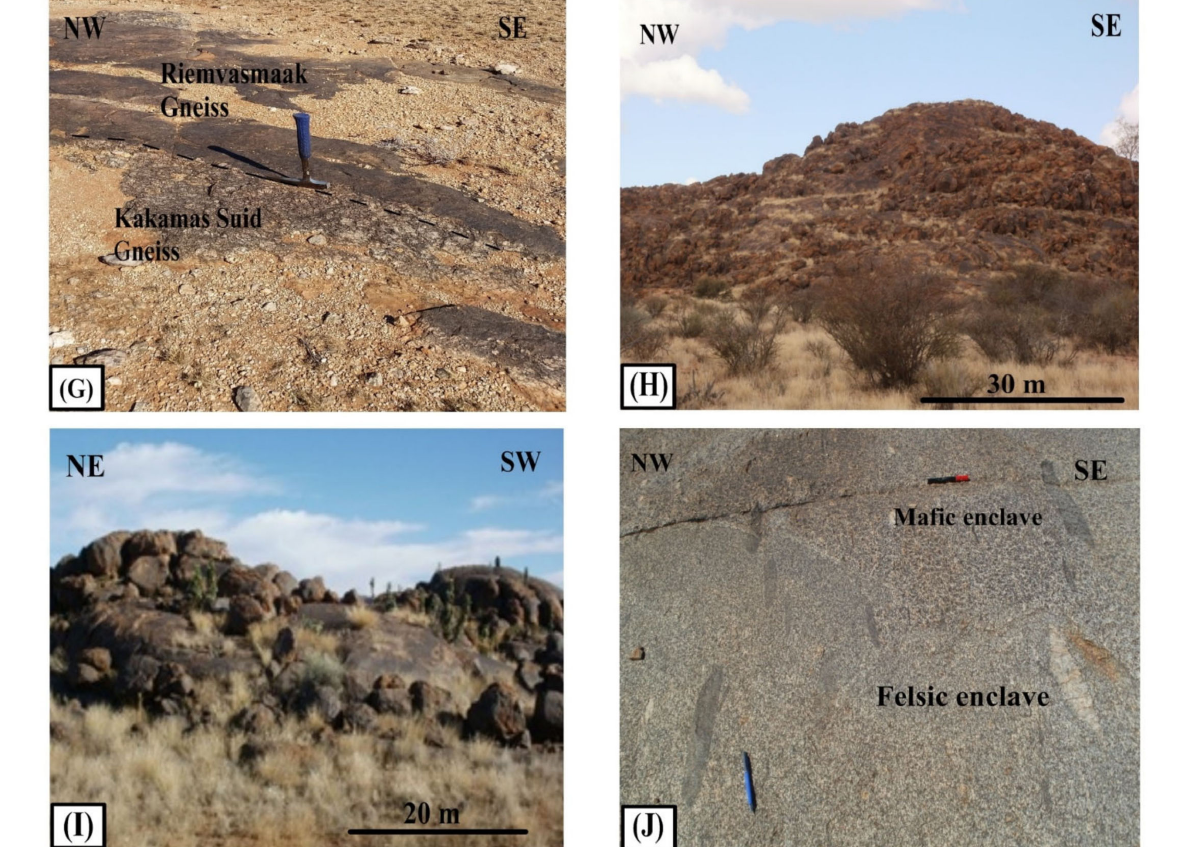
Figure 4. Stratigraphic profile along the representative section line A-A’ west of the Neusberg Mountain. The location of the section is given in Figure 3. ( A ) Intercalated layers of calc-silicate-rich quartzite with brown amphibole schist exhibiting well-preserved northeast-dipping S 0 foliation parallel to S 1 in metasediments of the Puntsit Formation in the Neusberg Mountain (white line is the edge of the notebook). ( B ) Crossbedding observed in the feldspathic mica-rich quartzite of the Goede Hoop Formation and defined by the compositional banding (S 0 ). The younging direction is top normal towards the northeast. ( C ) Outcrop of feldspathic mica-rich quartzite dipping northeast, showing the XZ-plane of the strain ellipsoid defined by the elongated pebbles in the outcrop surface. ( D ) Upward fining cycle in the feldspathic mica-rich quartzite of the Goede Hoop Formation. ( E ) Outcrop of the Kakamas Suid Gneiss displaying an augen structure. The fabric is defined by elongate quartzo-feldspathic sigmoidal-like structures. The XZ-plane of the strain ellipsoid is defined by the elongated aggregates of quartz-feldspar in the outcrop surface. ( F ) Photomicrograph of the Kakamas Suid Gneiss showing well-delineated quartz-feldspar augen. Abbreviations: Qtz = Quartz; Or = Orthoclase; Mc = Microcline; Hbl = Hornblende; Bt = Biotite. ( G ) Sharp contact between the Riemvasmaak Gneiss and the Kakamas Suid Gneiss. The contact is demarcated by a black dotted line. ( H ) Panoramic view of the distribution of the Warm Zand leucogneiss as small and separated hills, looking to the southeast between the Neusberg and Vuurkop Mountains. ( I ) Exfoliated rocks of the Friersdale Charnockite, looking to the northeast along the contact zone. ( J ) Medium-grained granoblastic texture of the Friersdale Charnockite with enclaves of mafic and felsic